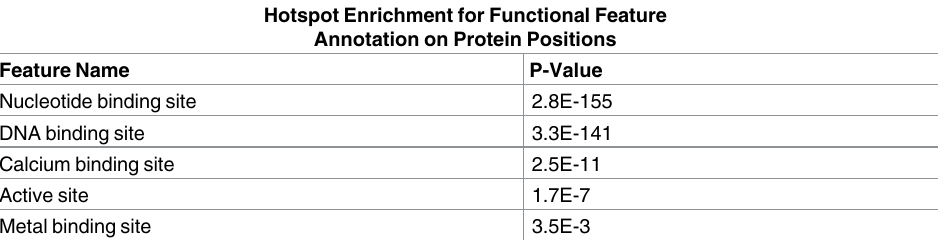
Table 2. Enrichment of residues with functional feature